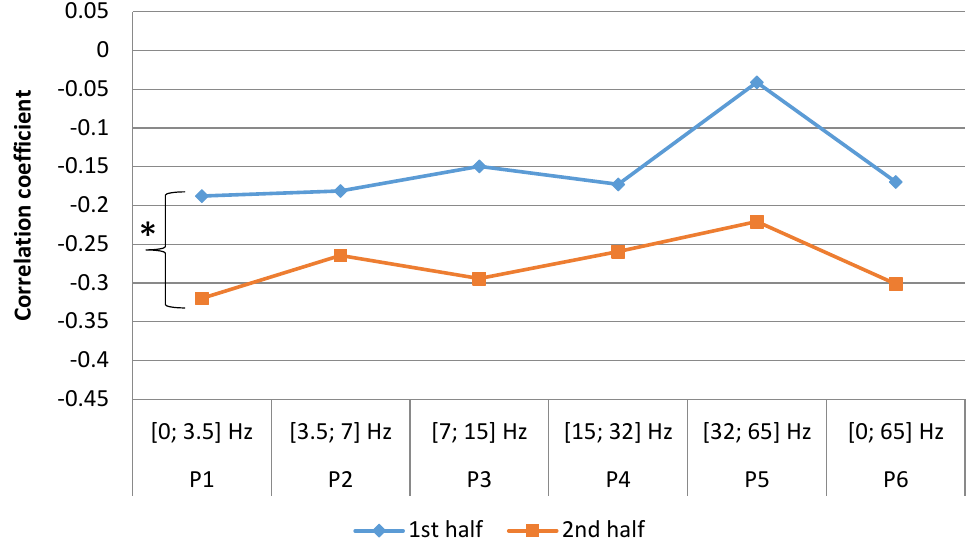
Figure 10. Correlation between number of men weekly cases of MI and mean magnetic power in different frequencies for younger (<63 years) men group for first and second half for year 2016 (data from LUHS, Cardiology clinic, 2016), * p < 0.05.